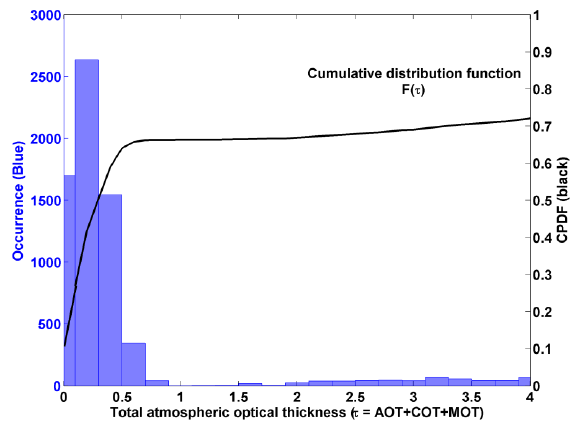
Figure 14. Blue bars: distribution 1 of total atmospheric optical thickness τ at 1064 nm for one revisit cycle (26 days) of the satellite over the two selected areas: Congo basin (Africa, tropical forest) and Lake Baïkal (Russia, boreal forest) with 2 satellite orbits (ISS and ICESat). Black curve: cumulative probability density functions (CPDF) of τ. The number of the lidar shots following ISS/ICESat orbit inside each selected area is given, as well as the corresponding valid value number of τ given by MODIS. 1 The distribution is truncated at